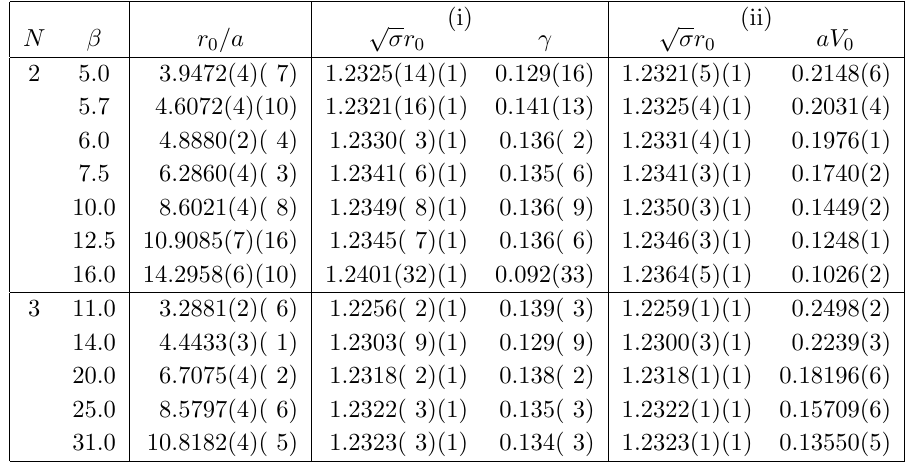
Table 3 . Results for the Sommer parameter r 0 and the string tension (cid:27) in units of r 0 from methods (i) and (ii), as explained in the text. Also listed are the other (cid:12)tparameters, the L(cid:127)uscher constant (cid:13) and the normalisation constant V 0 .